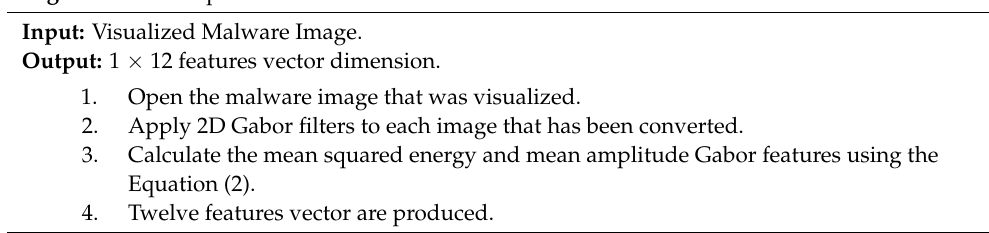
Algorithm 3: Compute Gabor textures